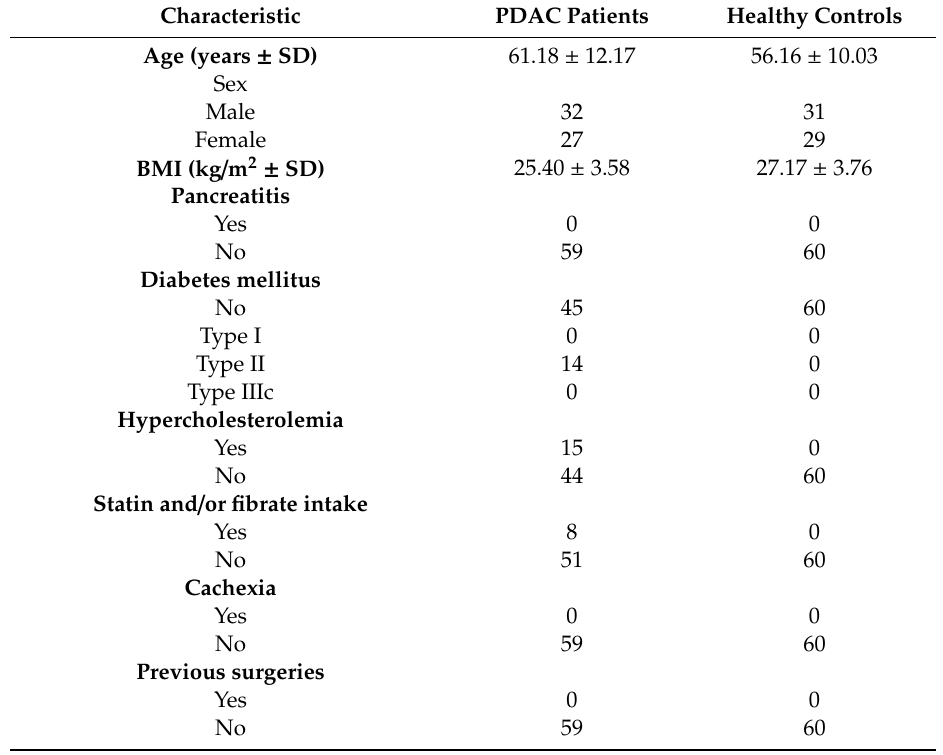
Table 4. Baseline characteristics of all study